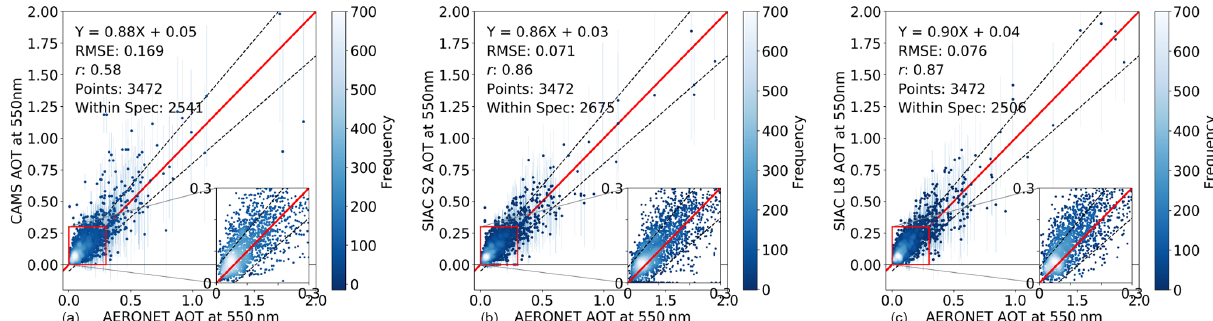
Figure 4. AOT validation against AERONET measurements from CAMS (a) , SIAC S2 (b) , and SIAC L8 (c) over 3466 matches, where the vertical lines of each point are the uncertainty of solved AOT values, and the horizontal error bars are AERONET measurement uncertainty of 0.01. On three panels, the inset plot shows the region marked by the red square in more detail, with 0 ≤ AOT ≤ 0 . 3. The threshold uncertainty is shown as black dashed lines in the figure.